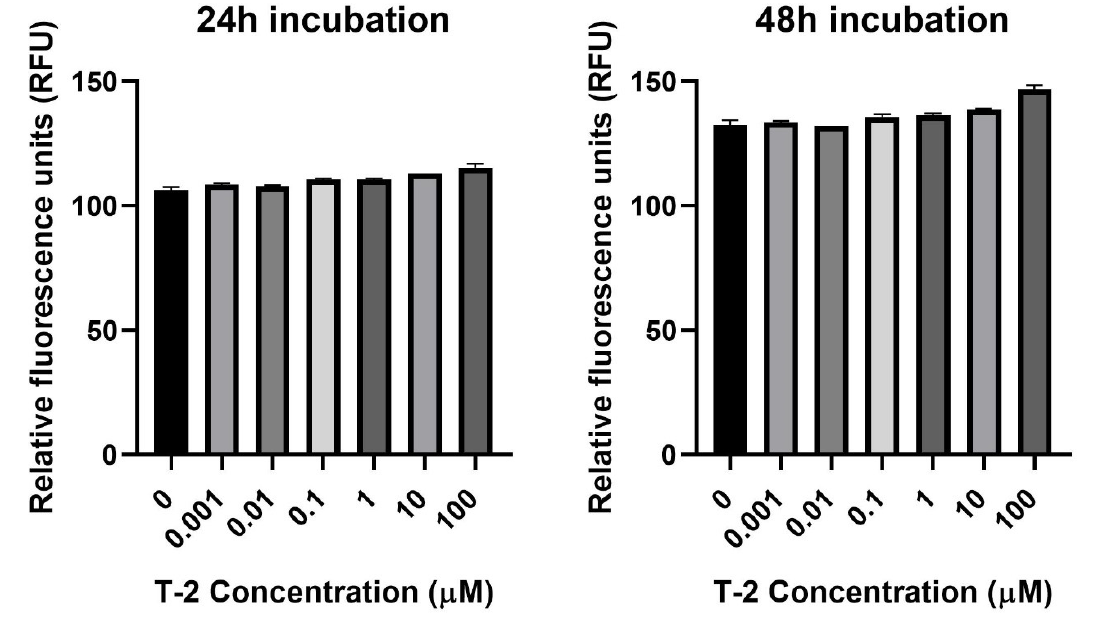
Figure 2. The T-2 toxin’s effect on intracellular ROS production in the Hs68 cell line, measured as the DCF fluorescence intensity. The values are presented as means ± SD (n = 6).